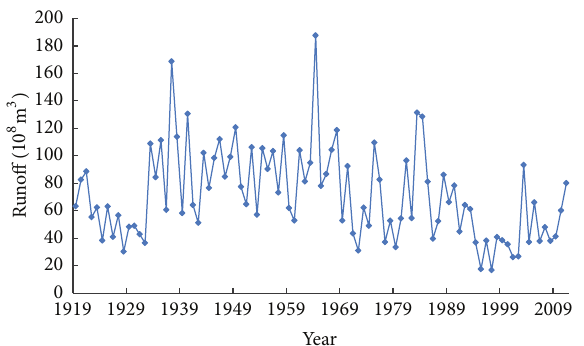
Figure 2: Annual runoff volumes in the Weihe River at the Huaxian hydrological station from 1919 to 2011.